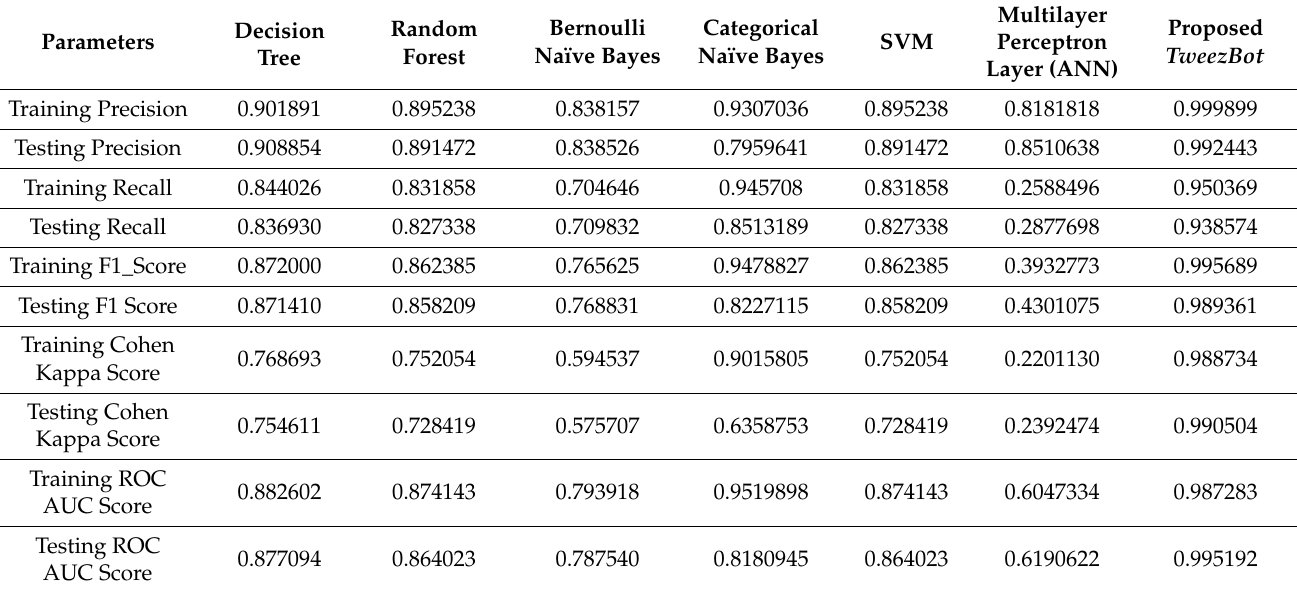
Table 4. Comparative Study of Classification Parameters of Benchmark Classifiers & Proposed TweezBot